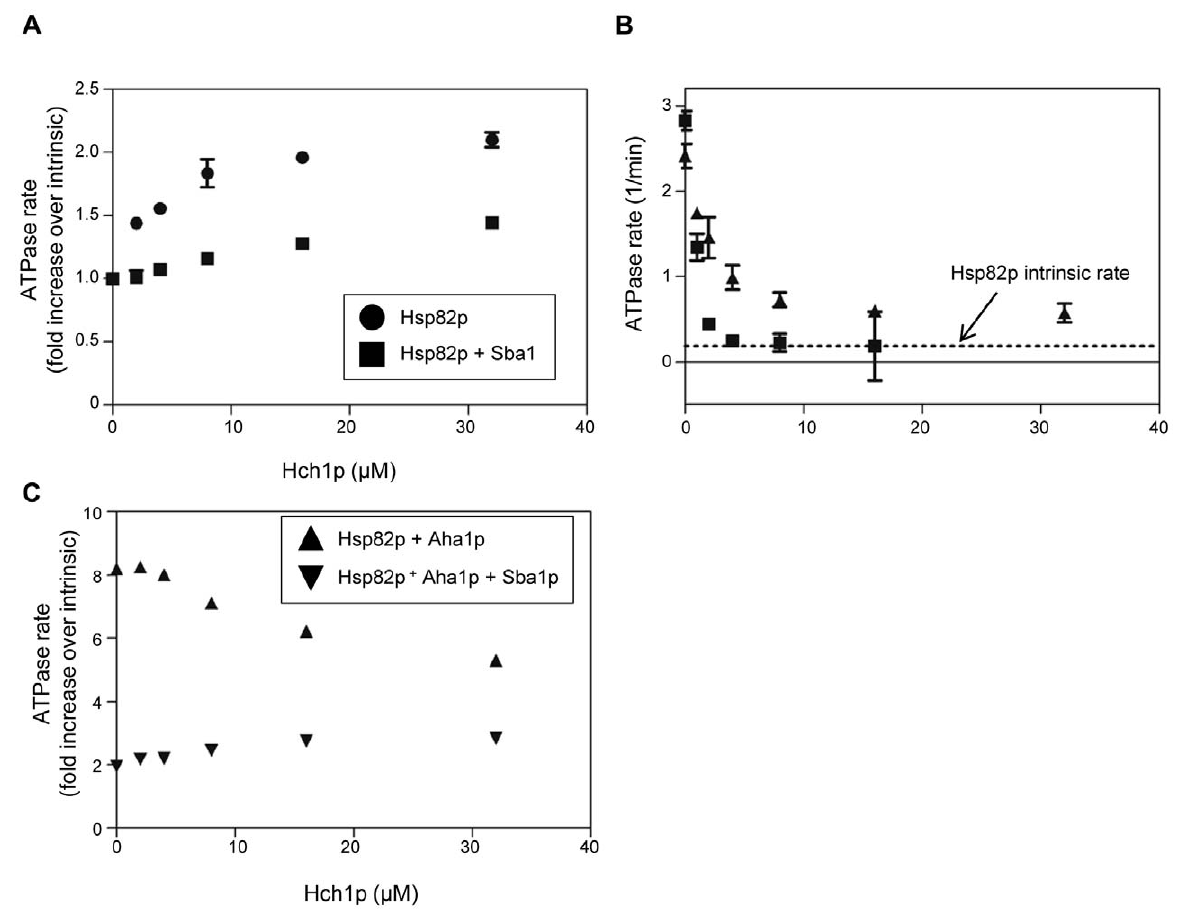
Figure 7. Co-chaperone competition in Hsp82p ATPase reactions. A. Stimulation of the ATPase activity of wildtype Hsp82p (2 m M) by increasing concentrations of Hch1p in the presence (squares) or absence (circles) of Sba1p (8 m M). ATPase rate shown as a fold increase over intrinsic rate of Hsp82p alone. B. Inhibition of Aha1p-stimulated ATPase rate by increasing concentrations of Sba1p (triangles) and Sti1p (squares). Dashed line represents intrinsic Hsp82p ATPase rate. Reactions contain 2 m M Hsp82p, 4 m M Aha1p and indicated concentrations of Sba1p or Sti1p. ATPase rate shown in m M ATP hydrolyzed per minute per m M of enzyme (1/min). C. Effect of increasing concentrations of Hch1p on the Aha1p-stimulated ATPase activity of wildtype Hsp82p (2 m M) in the presence (squares) or absence (circles) of Sba1p (8 m M). ATPase rate shown as a fold increase over intrinsic rate of Hsp82p alone. Reactions contained 2 m M Hsp82p and indicated concentration of Aha1p or Hch1p.